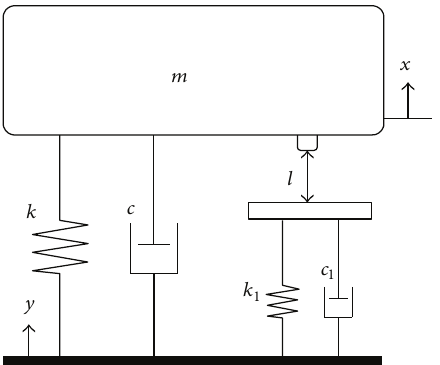
Figure 10: Piecewise linear model of the forced vibration-based impact mode piezoelectric power